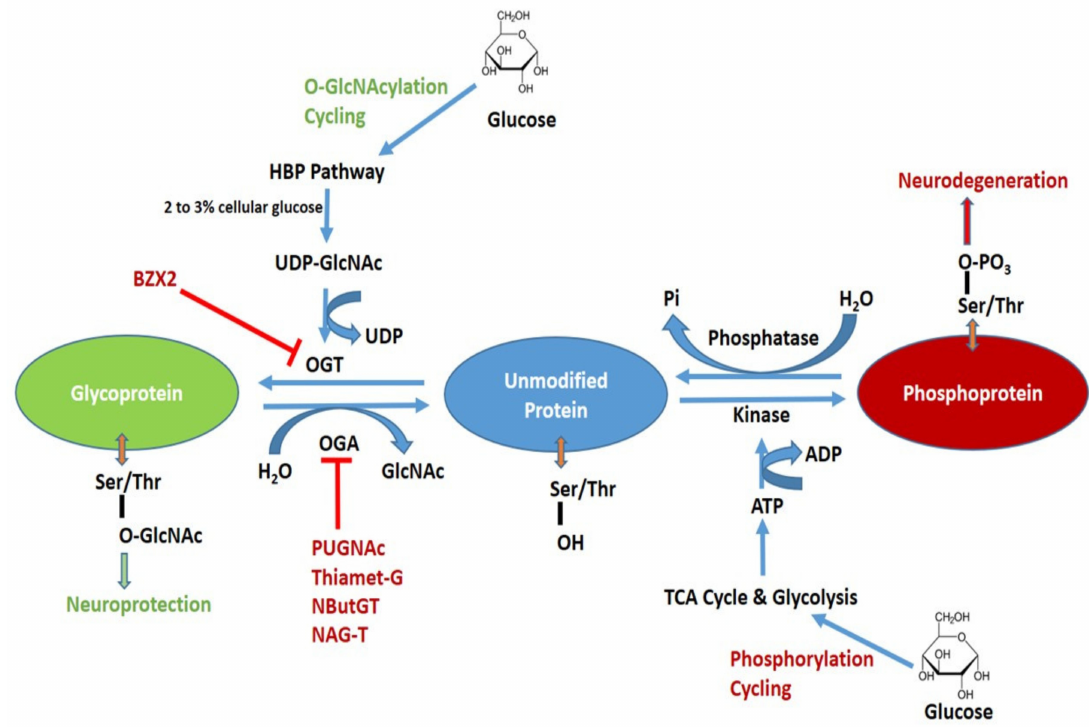
Figure 1. Schematic diagram of O-GlcNAcylation and phosphorylation processes of protein and their possible pharmacological interventions. Hexosamine biosynthetic pathway (HBP) leads to UDP-GlcNAc formation and regulates O-GlcNAcylation. O-GlcNAc transferase (OGT) is inhibited by BZX2 whilst O-GlcNAcase (OGA) is inhibited by PUGNAc, Thiamet-G, NButGT and NAG-T. These OGT and OGA inhibitors are targeted to modulated O-GlcNAc levels in neurodegenerative diseases. Tricarboxylic acid (TCA) and glycolysis cycle regulate protein phosphorylation. Kinase and phosphatase regulate phosphorylation and dephosphorylation,